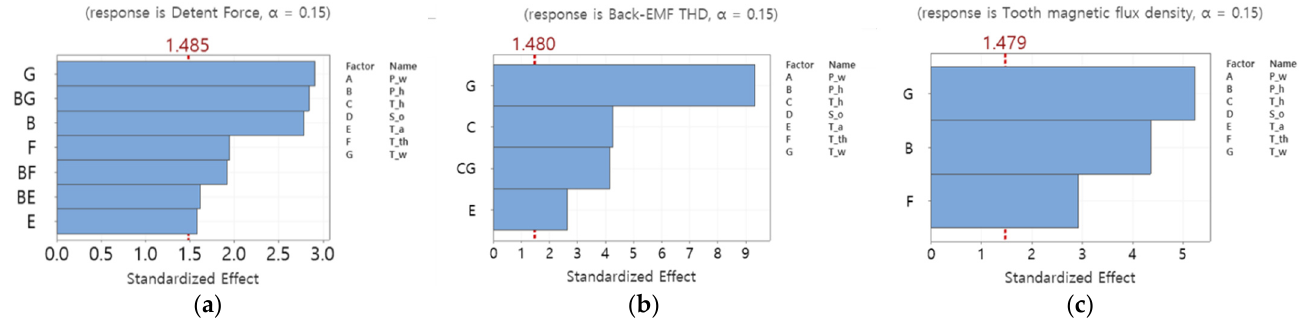
Figure 7. Pareto chart of the standardized effects: ( a ) Detent force; ( b ) Back EMF; ( c ) Magnetic flux density.